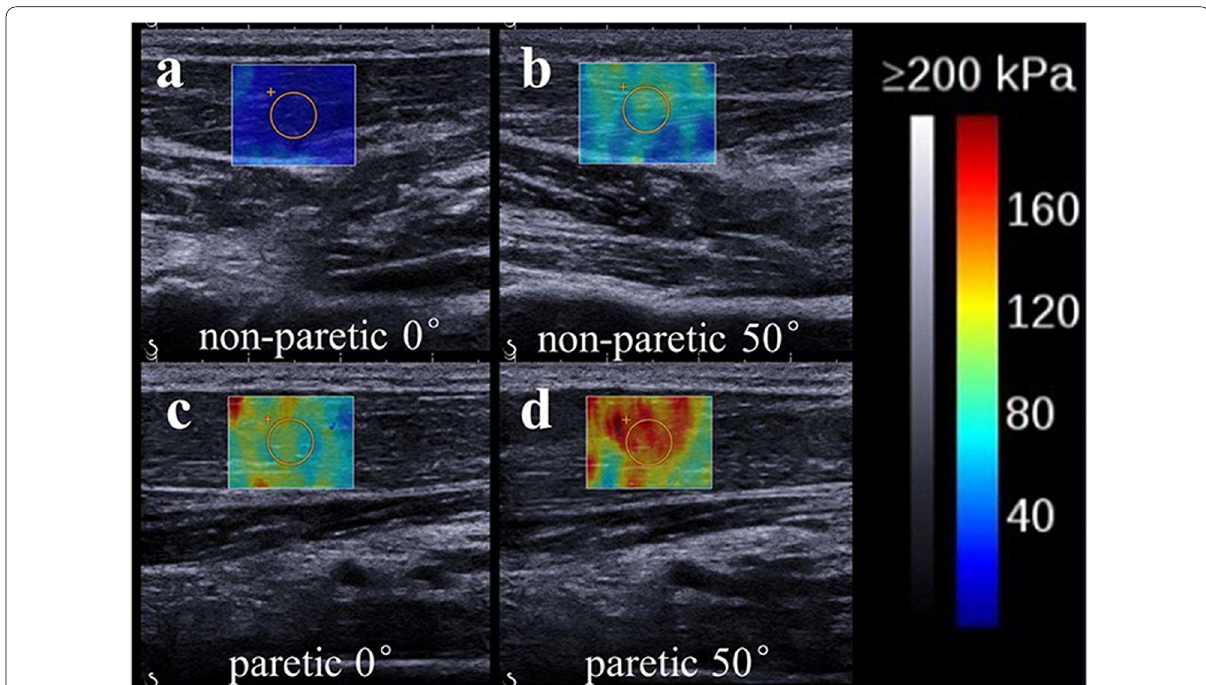
Fig. 2 SWE superimposed on the B-mode ultrasound image of the muscles of the ( a ) neutral non-paretic, ( b ) stretched non-paretic, ( c ) neutral paretic and ( d ) stretched paretic forearm. From Leng et al. (2019)